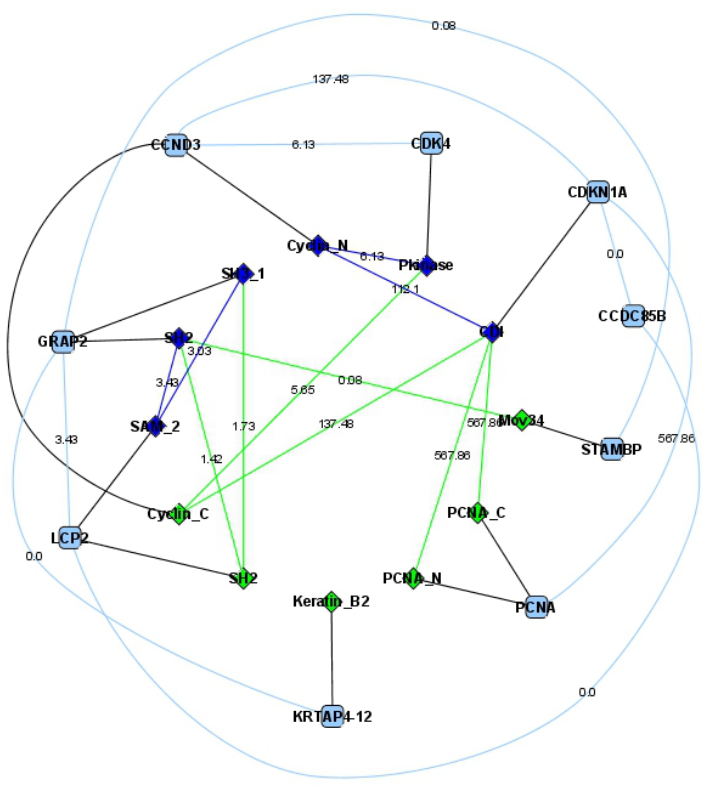
Figure 8: Intersection graph computed of the domain graphs in Figures 1 and 2. Nodes and edges contained in both domain graphs with di ff erent type annotation are colored dark